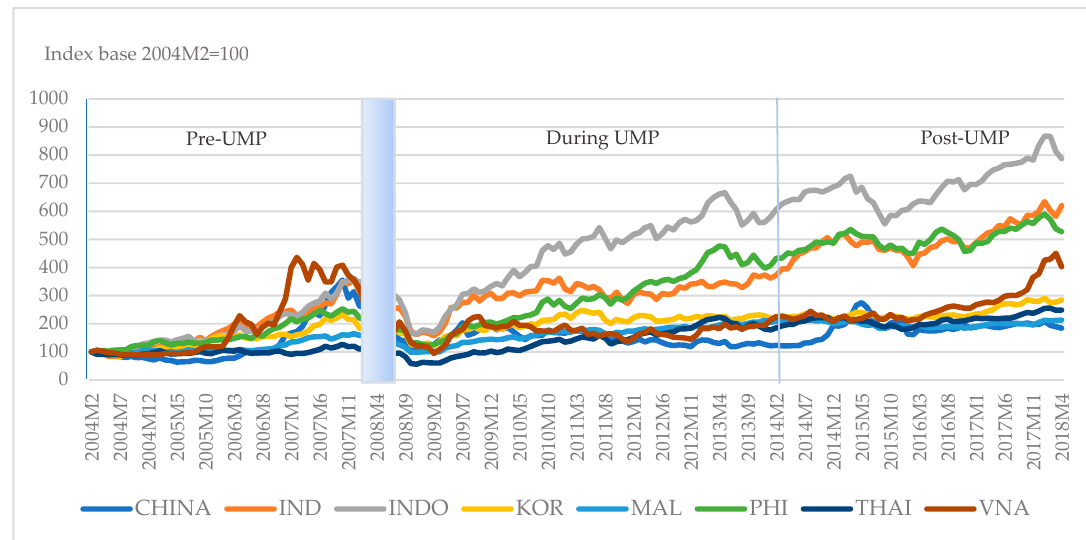
Figure 3. Equity prices in Asian developing countries for the whole period (source: Bloomberg). CHINA = China; IND = India; INDO = Indonesia; KOR = Korea; MAL = Malaysia; PHI = Philippines; THAI = Thailand; VNA = Vietnam. Crisis period.